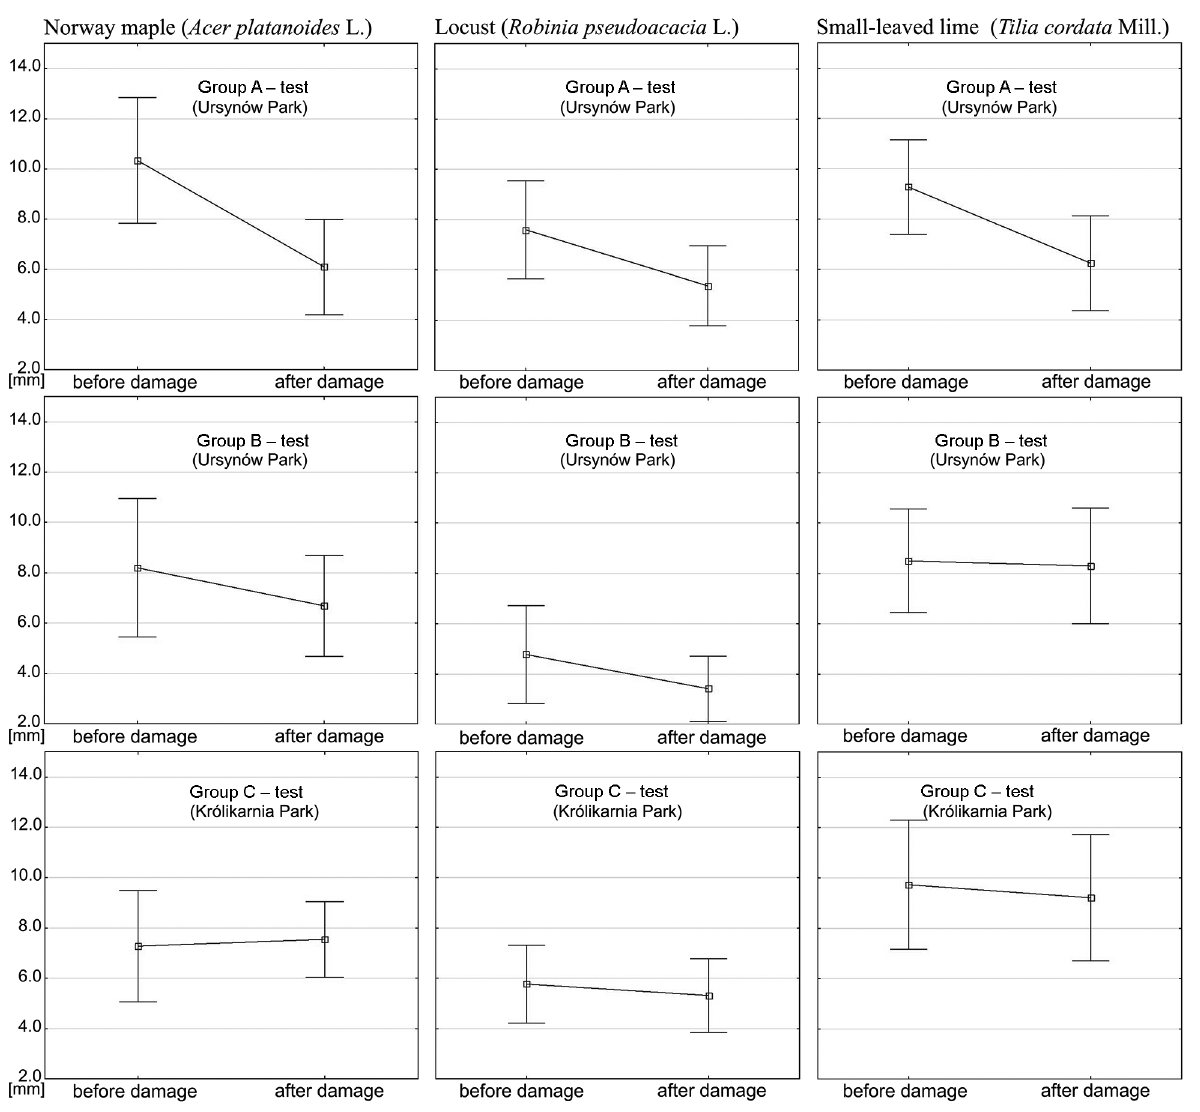
Figure 2. The verification of the effectiveness of the circumference measurements (Figure 1). The standardization of the average annual radial wood increment [mm] and the adequate values of the standard deviation ± s [mm] before and after the certain point of time, when earthworks around trees in Ursynów Park were completed. The results: the response of average annual radial wood increment obtained for groups A and B – test (Ursynów Park) in comparison with the group C – control (Królikarnia Park), within each of selected tree species abundant in both